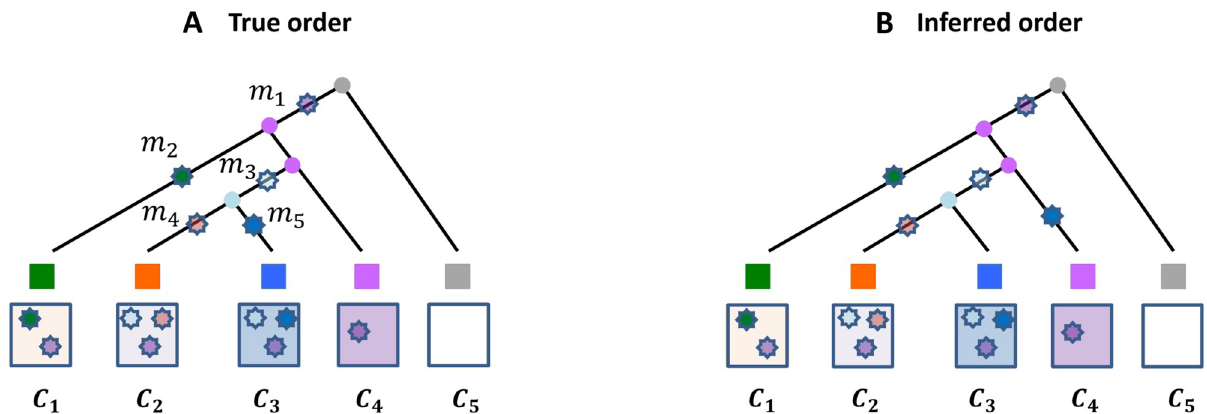
Fig 8. Example measures of accuracy (A) True mapping of mutations along a fixed phylogenetic tree; (B) Inferred mapping of mutations along the same phylogeny. The adjacent order accuracy is 2/3, while the order accuracy is 5/6.